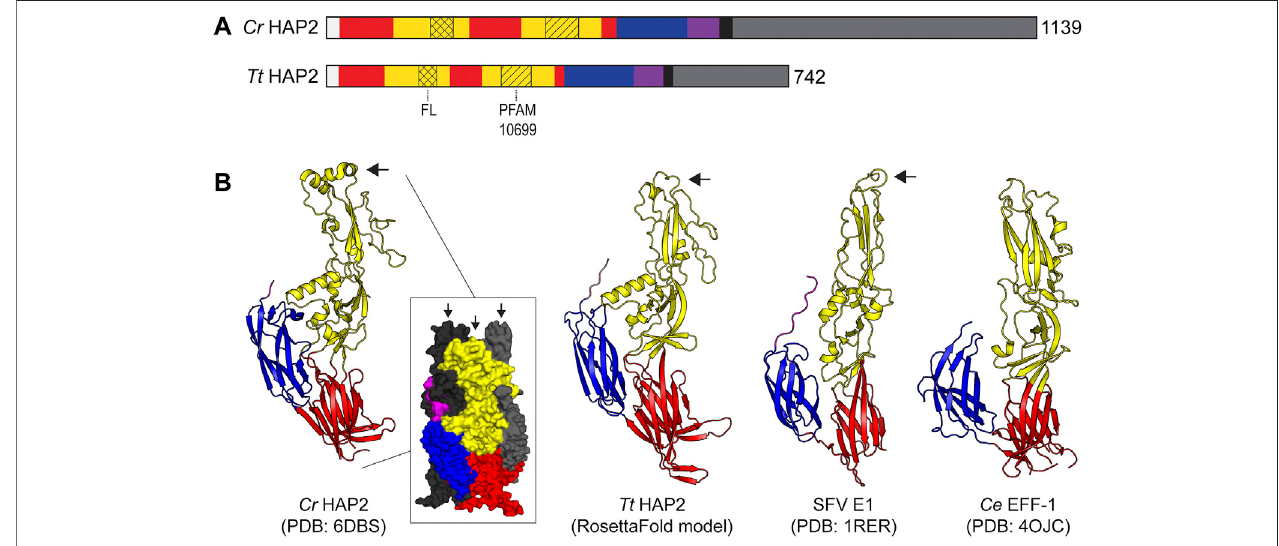
FIGURE3| HAP2Proteindomainsandstructure. (A) ProteindomainschematicshowingtheorganizationofHAP2monomersfromN ′ toC ′ terminus (lefttoright) from T. thermophila (Tt) and C. reinhardtii (Cr). The signal peptide is white; domain I is red; domain II is yellow; fusion loop (FL) is indicated with crosshatch; PFAM10699 (HAP2/GCS1 domain) is indicated with diagonal lines; domain III is blue; stem is purple; transmembrane domain is black; and, the cytoplasmic domain is gray. The number of amino acids in each protein is shown on the far right at the C ′ terminus. (B) X-ray and model ectodomain protein structures showing the homology of HAP2 and other class II fusogens from viruses and cells. From left to right: the crystal structure of the C. reinhardtii HAP2 post-fusion trimer with one cartoon protomer (left) andasurfacerepresentationofthetrimer(inset)withcoloreddomainsonthefrontprotomerandthetwobackprotomersinblackandgray,respectively(Fengetal., 2018); a RosettaFold model protein structure of a Tetrahymena HAP2 monomer (Baek et al., 2021); a single protomer from the trimeric crystal structure of the Semliki Forest Virus E1 class II fusion protein (Gibbons et al., 2004); a single protomer from the trimeric crystal structure of the C. elegans class II cell-cell fusion protein EFF-1 (Perez-Vargas et al., 2014). Black arrows point to the fusion loops. Protein databank IDs (PDB) are shown below the images.